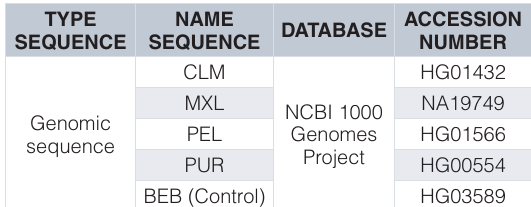
Table 1. Accession numbers of the four Latin American human genome variants obtained from the NCBI 1000 genomes